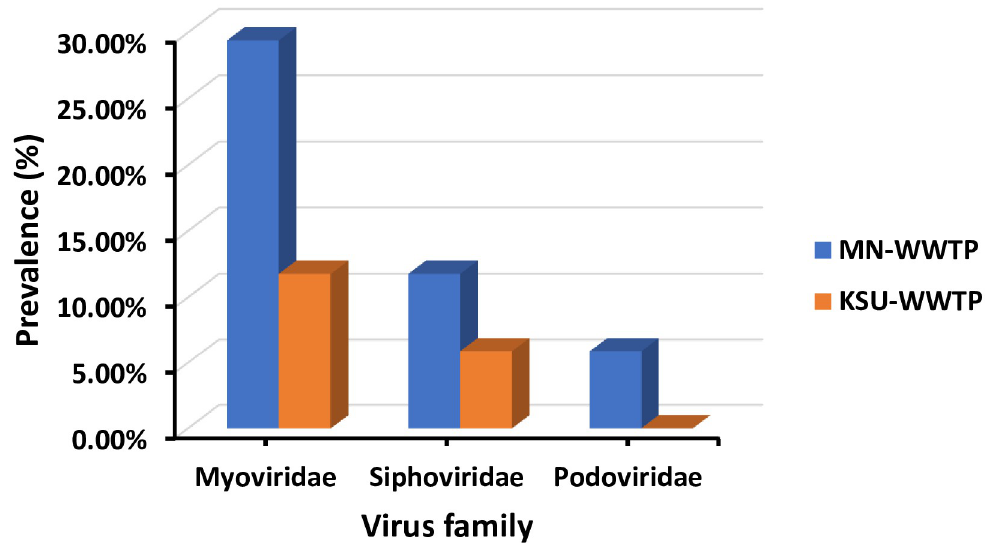
Fig 3. Prevalence of phage families in WWTPs.